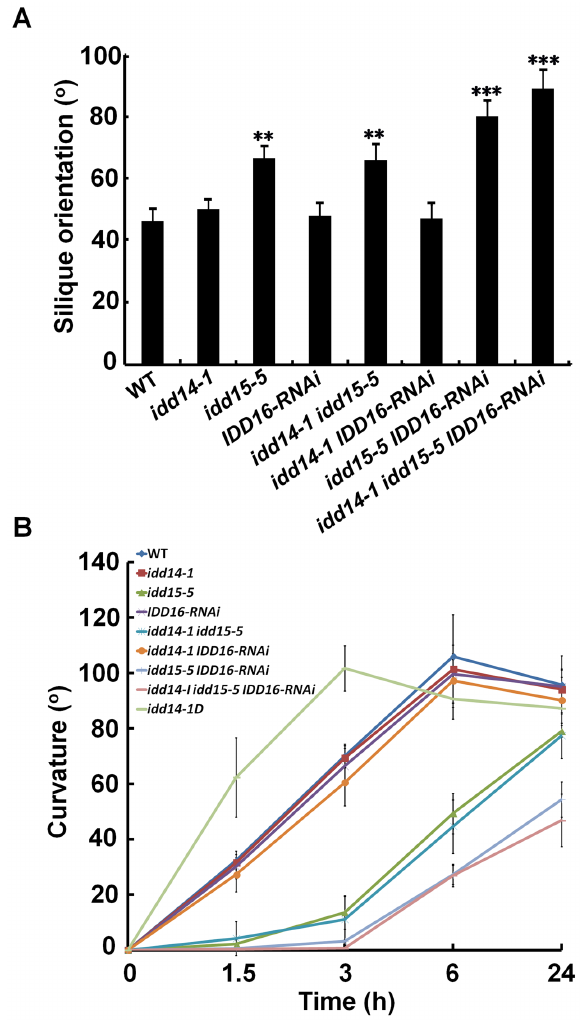
Figure 5. Silique orientation and gravitropic response in gain- and loss-of-function idd mutants. (A) Silique orientation in the idd single, double, and triple mutants. The angles between siliques and inflorescence stems were measured in 45-day-old WT and idd mutant plants. The data are shown as mean values 6 one SD (Student’s t -test, **P , 0.01 and ***P , 0.001). (B) Gravitropic responses of inflorescence stems in idd14-1D and loss-of-function idd mutants. The degree of curvature was determined from at least 18 inflorescence stems in each genotype after gravistimulation at the indicated times. The data are shown as mean values 6 one